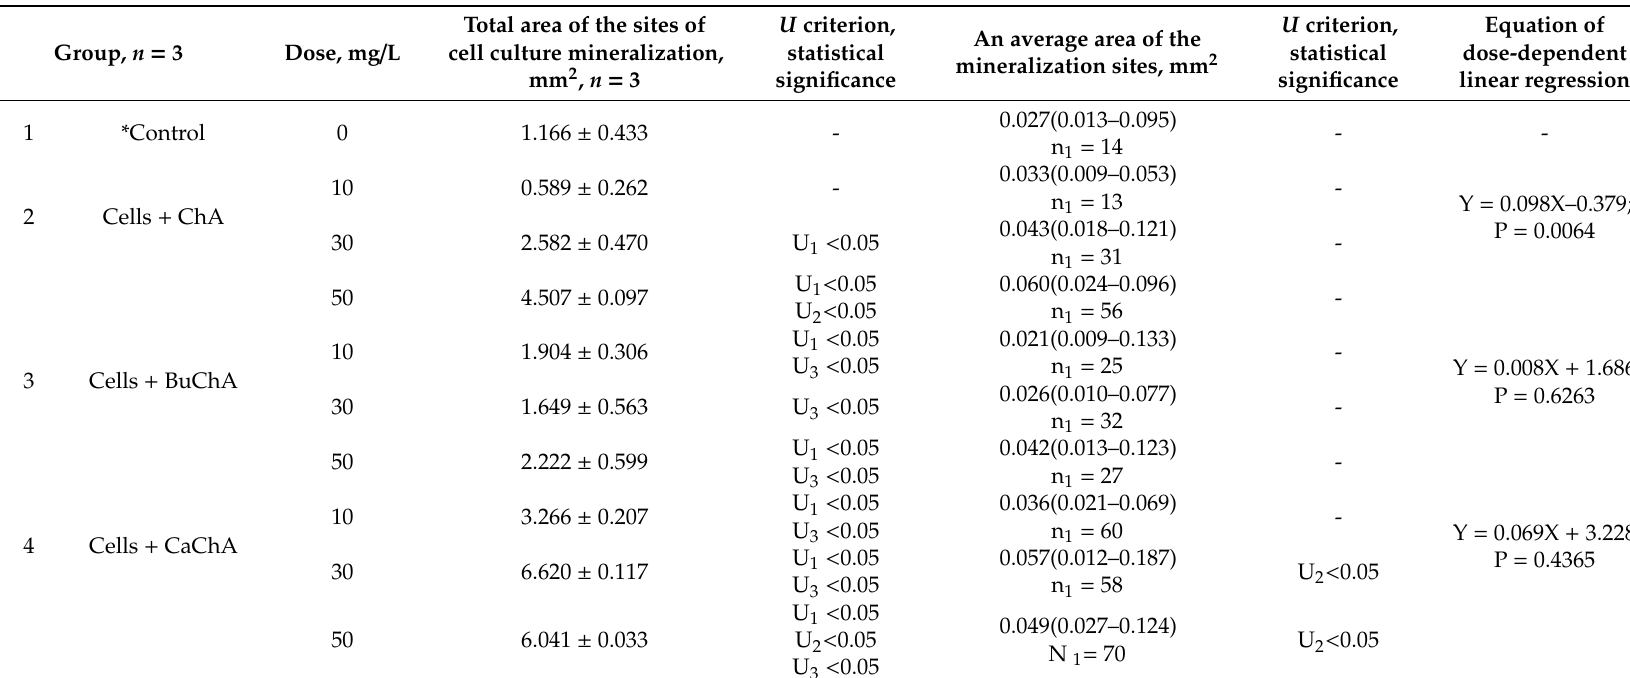
Table 2. In vitro e ff ect of the compounds on hAMMSC osteogenic di ff erentiation with mineralization of cell culture matrix, X ± SD, Me(Q1–Q3). Total area of the sites of U criterion, U criterion, Group, n = 3 Dose, mg / L